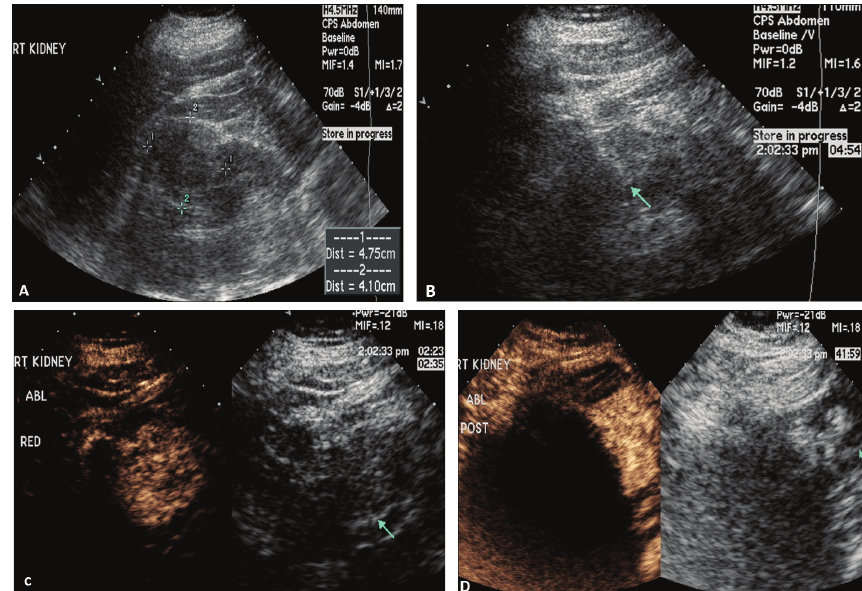
Figure 1. Images demonstrating RFA of an RCC. (A) B-mode image of the RCC (calipers) pre-procedure, (B) B-mode image demonstrating positioning of the RFA needle (arrow) in the RCC, (C) image after injection of ultrasound contrast confirming the needle (arrow on low MI B-mode image on right) within the tumor, and (D) CEUS post-procedure demonstrating complete ablation of the RCC (arrow,